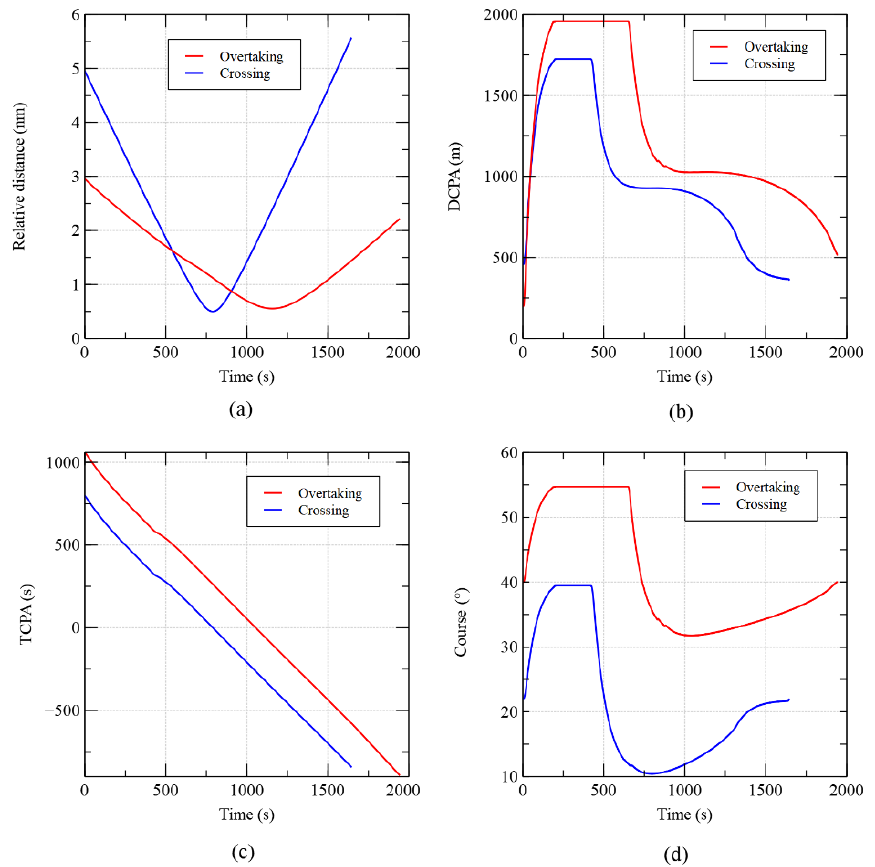
Figure 9. Real-time parameter changes under crossing situation and overtaking situation. ( a ) Relative distance between OS and TS; ( b ) DCPA between OS and TS; ( c ) TCPA between OS and TS; ( d ) the course of